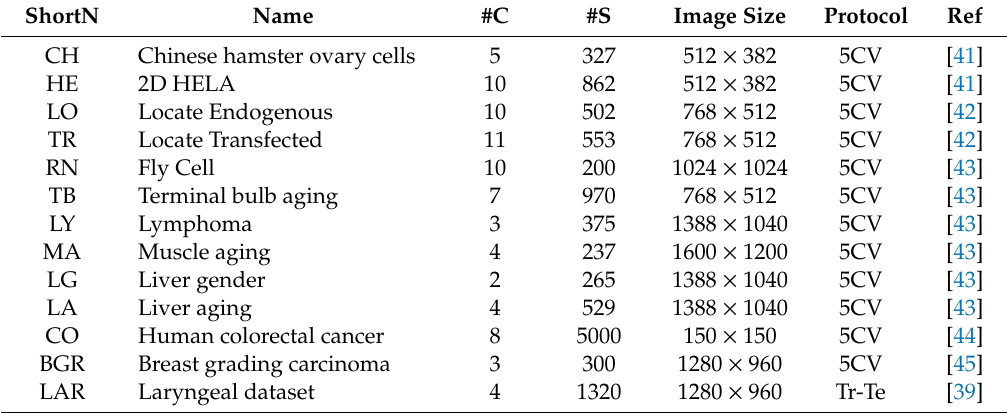
Table 3. Summary of the Medical Datasets for image classification: short same (ShortN), name, number